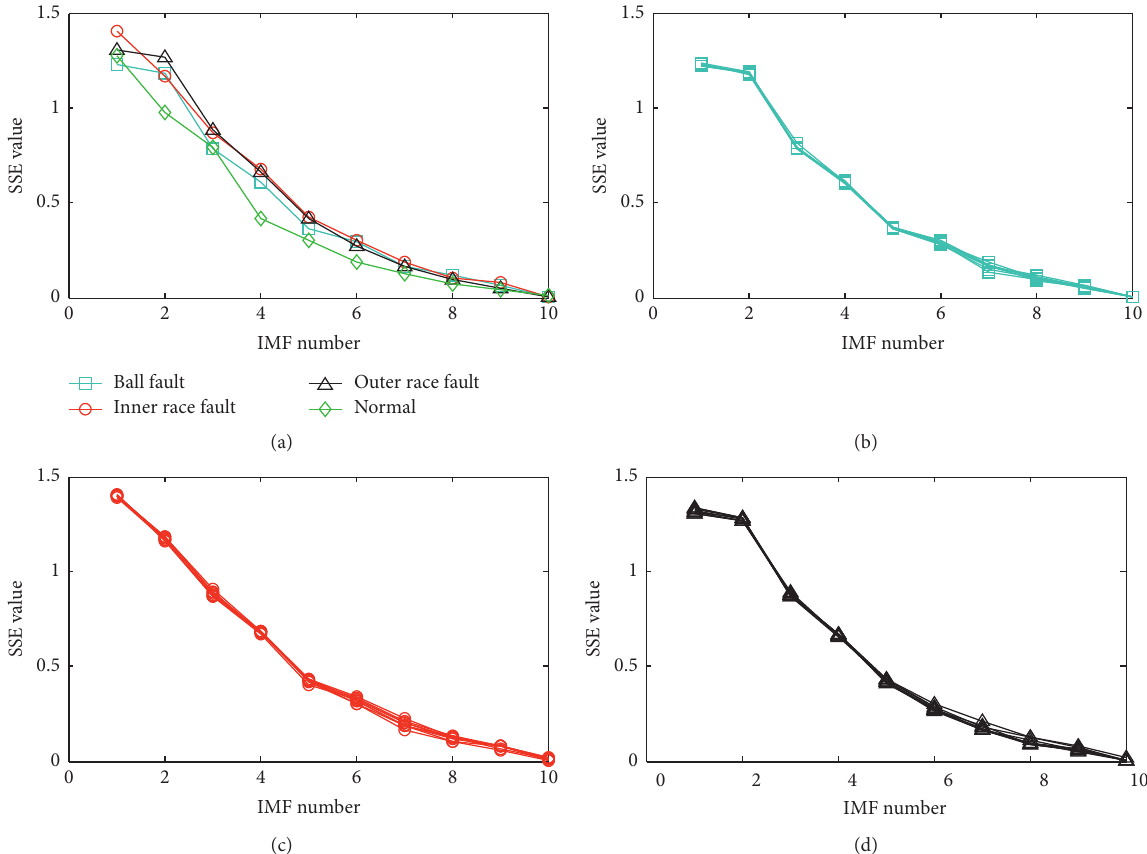
Figure 8: The distribution patterns of SSE on different IMF components. (a) The average SSE values of each IMF component of different fault conditions. (b) 8 samples of ball fault. (c) 8 samples of inner race fault. (d) 8 samples of outer race